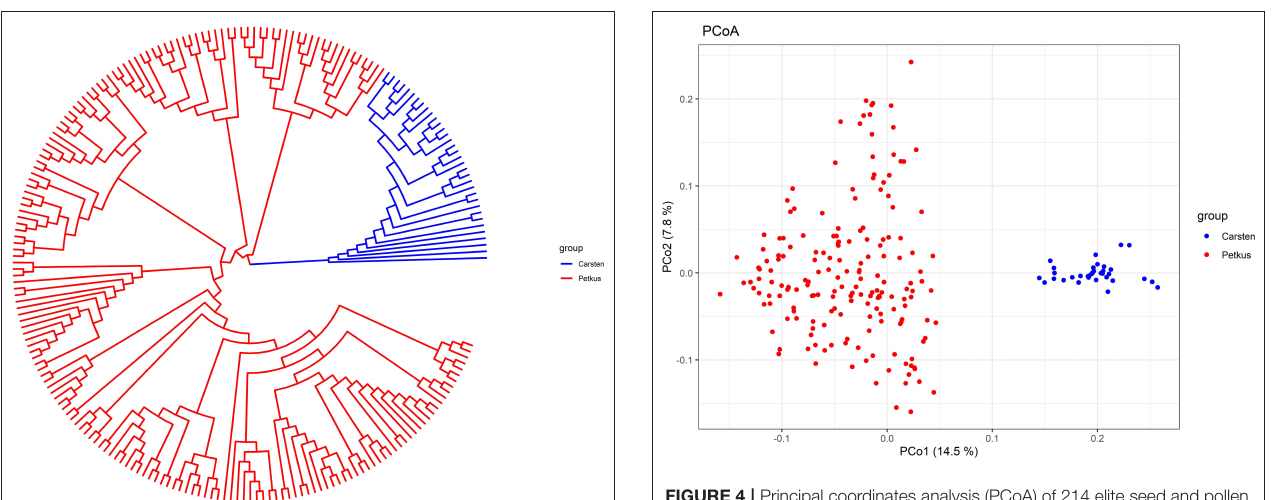
P450 CYP96B4 , the metal-nicotianamine transporter YSL2 , the amino acid transporter AAP6, the ATP-binding cassette